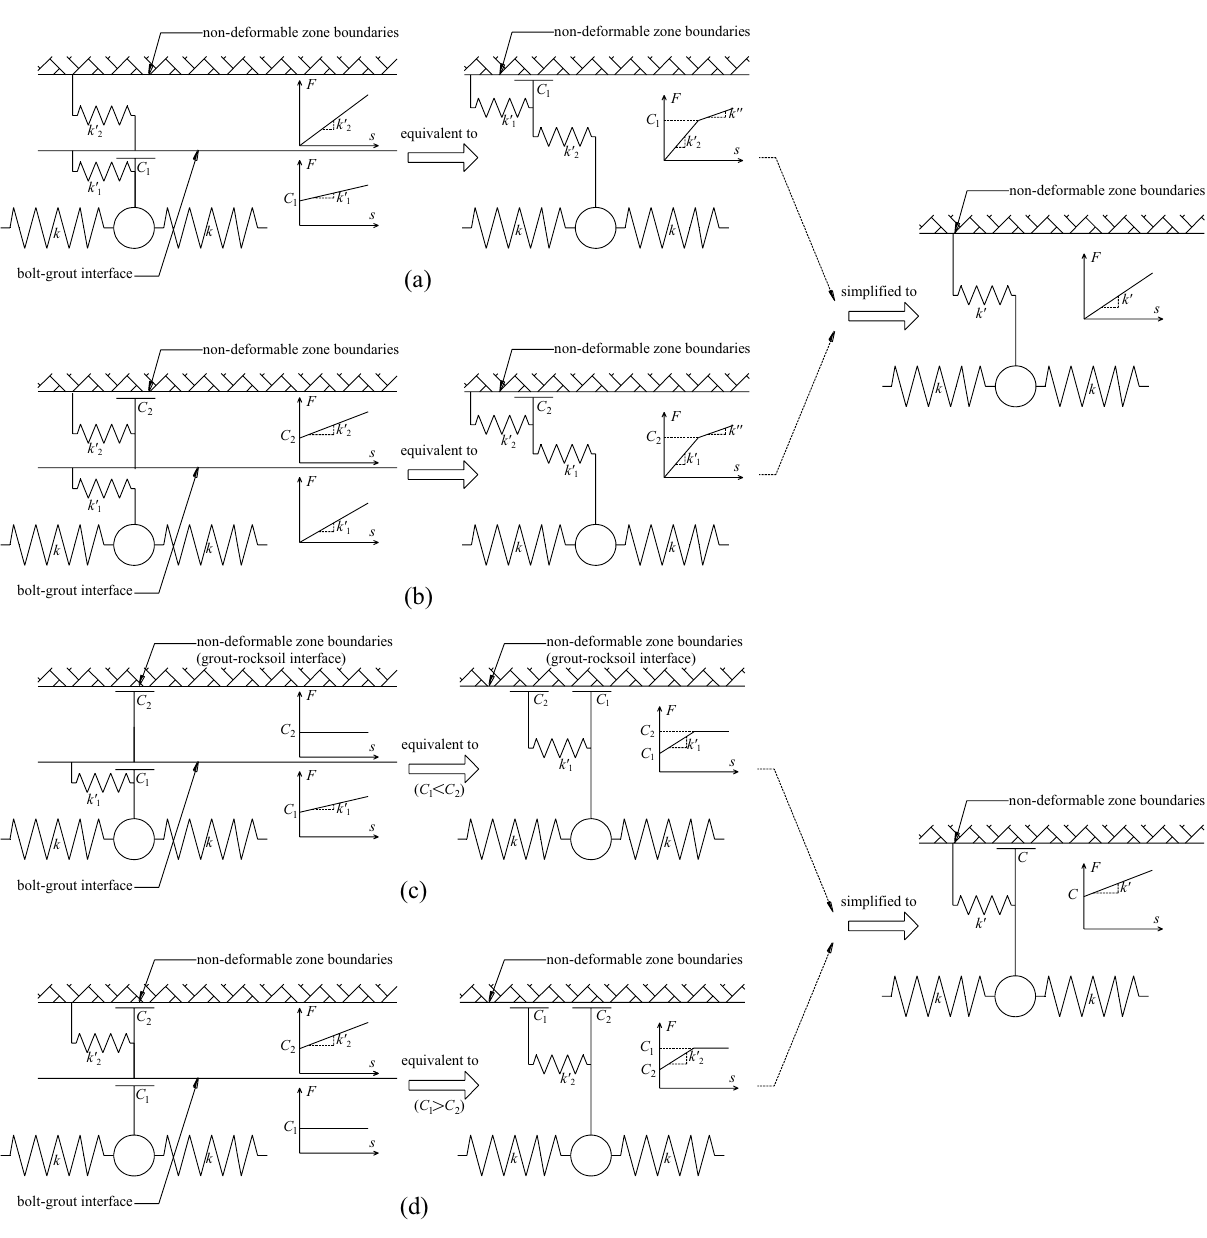
Figure 10. Several special cases. ( a ) When the bolt–grout interface is combinatorial coupling, and the grout– rocksoil interface is mechanical interlock; ( b ) When the bolt–grout interface is mechanical interlock, and the grout–rocksoil interface is combinatorial coupling; ( c ) When the bolt–grout interface is combinatorial coupling, and the grout–rocksoil interface is friction; ( d ) When the bolt–grout interface is friction, and the grout–rocksoil interface is combinatorial